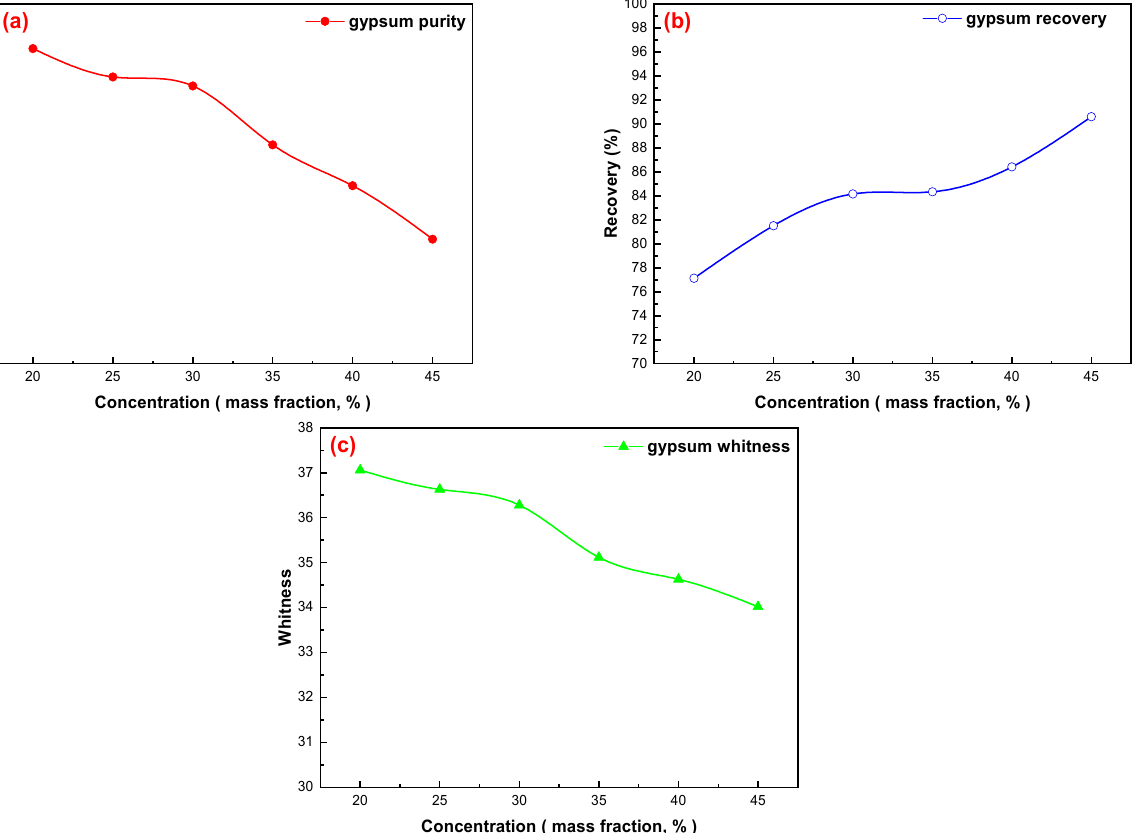
Figure 5. Effects of flotation concentration on gypsum purification: ( a ) gypsum purity, ( b ) gypsum recovery, and ( c ) gypsum whiteness.